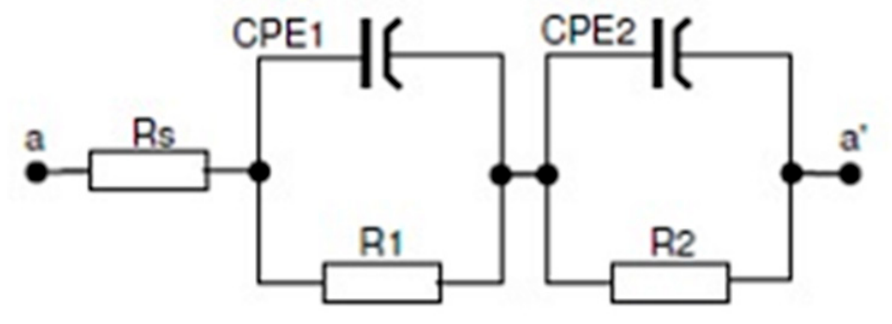
Figure 4. Equivalent electric circuits (EEC) for materials in artificial saliva solutions.